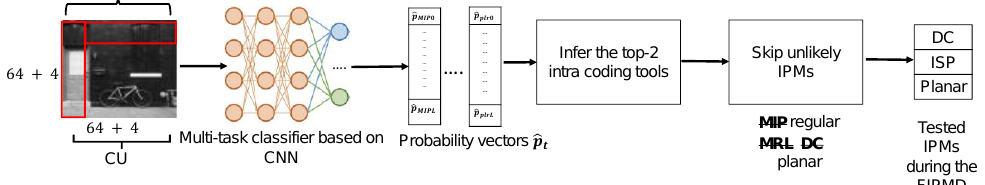
Figure 4. Workflow of MTL-based intra-mode decision framework. First, the luma block is fed to the MTL CNN to predict the probability vectors ˆ p MIP , ˆ p Reg , ˆ p MRL , ˆ p DC and ˆ p Plr . Then, the top-2 most likely intra-coding tools are inferred with the maximums of mean probabilities at each block. Finally, the FIPMD is performed only on IPMs of the top-2 intra-coding tools in order to decide the best IPM.